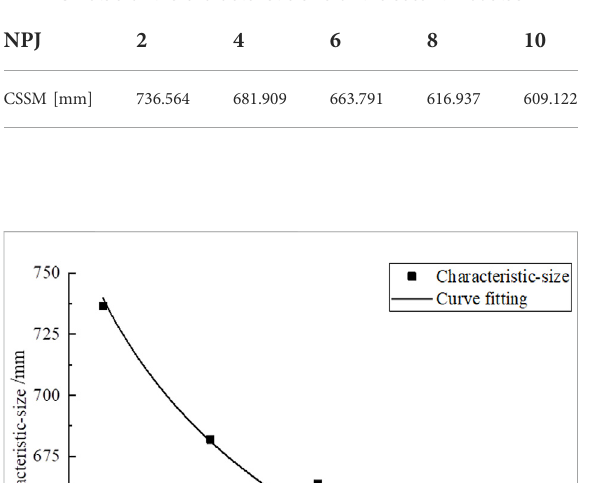
TABLE 10 Value of the characteristic secant modulus of the rock.